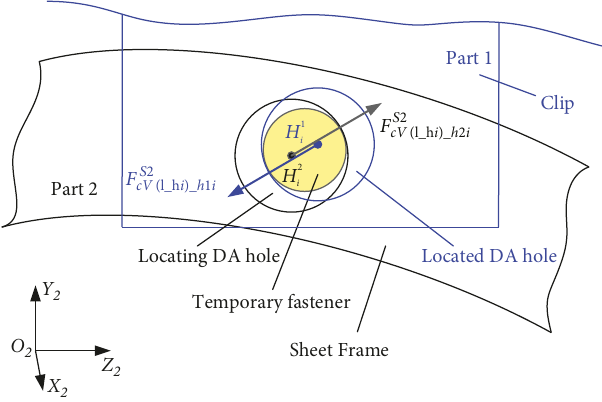
Figure 3: Clamping a DA hole-hole pair by temporary fastener ( i = 2, 3